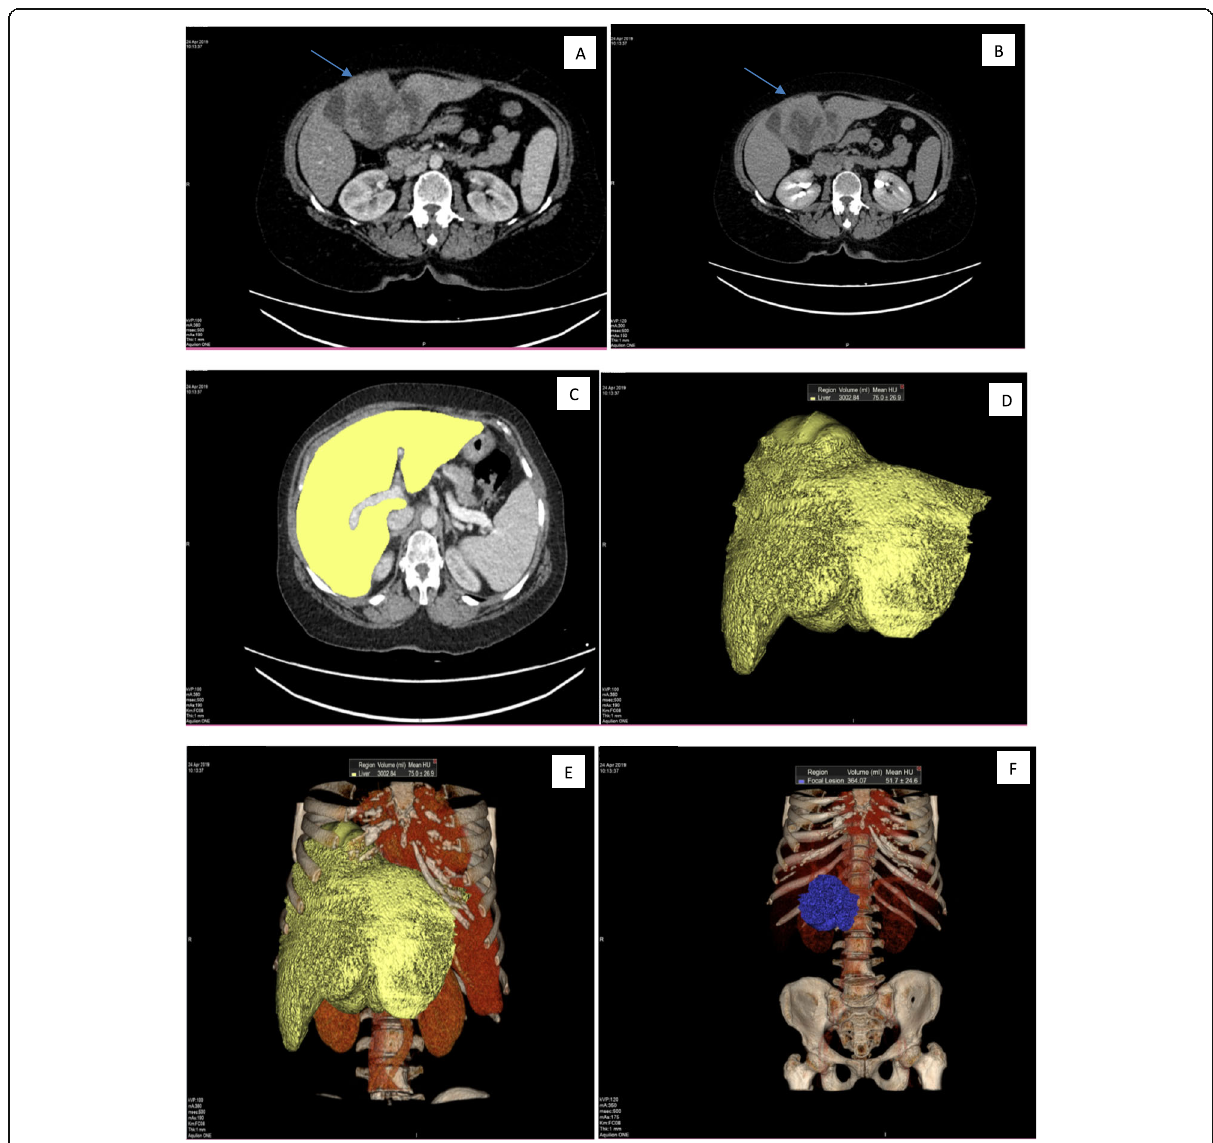
Fig. 2 Female patient aged 65years old, with left hepatic lobe focal lesion(HCC), triphasic CT examination axial arterial ( a ) and delayed ( b ) phase showing large left hepatic lobe focal lesion segment IV and III, showing faint peripheral enhancement in arterial ( a ) and venous phase (not shown) with washout in delayed ( b ) phase. c – e CT volumetry of whole live (volume = 3002.84ml). f CT volumetry of the focal lesion (volume =